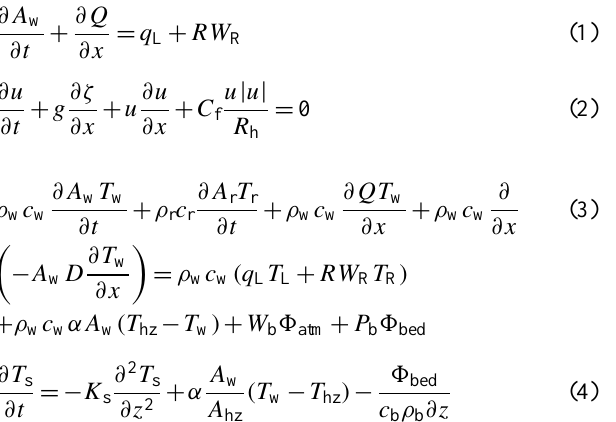
in the regolith. Hyporheic exchange (both upwelling